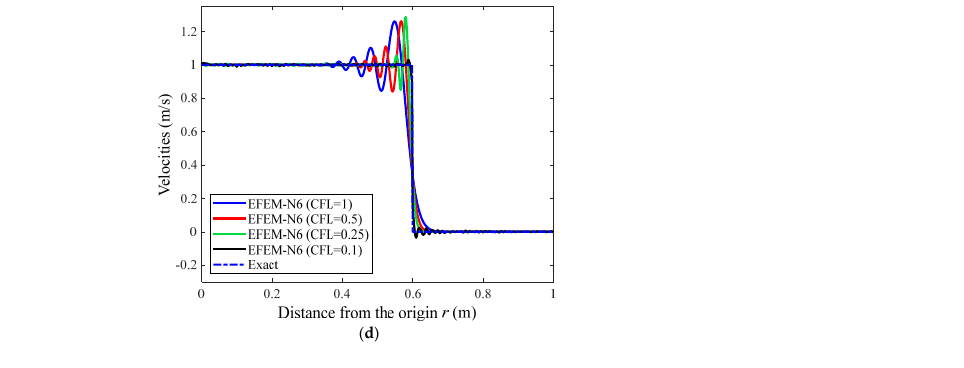
Figure 5. The velocity distributions of this elastic bar from various numerical approaches using the varying nondimensional time integration steps: ( a )FEM; ( b ) EFEM-N3; ( c ) EFEM-N9; ( d ) EFEM-N6.